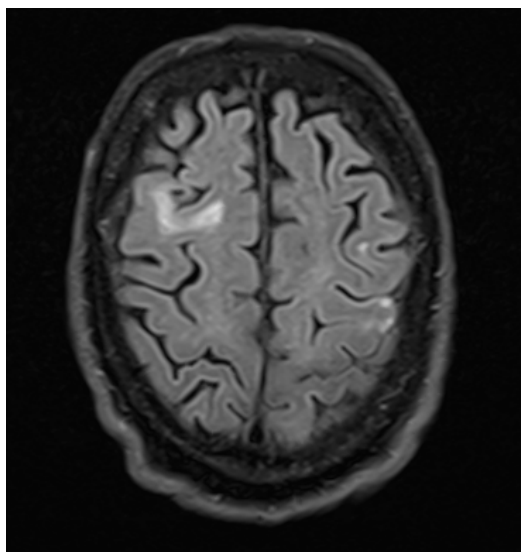
Figure 1. FLAIR cranial MRI image of the postoperative defect of the right FEF.